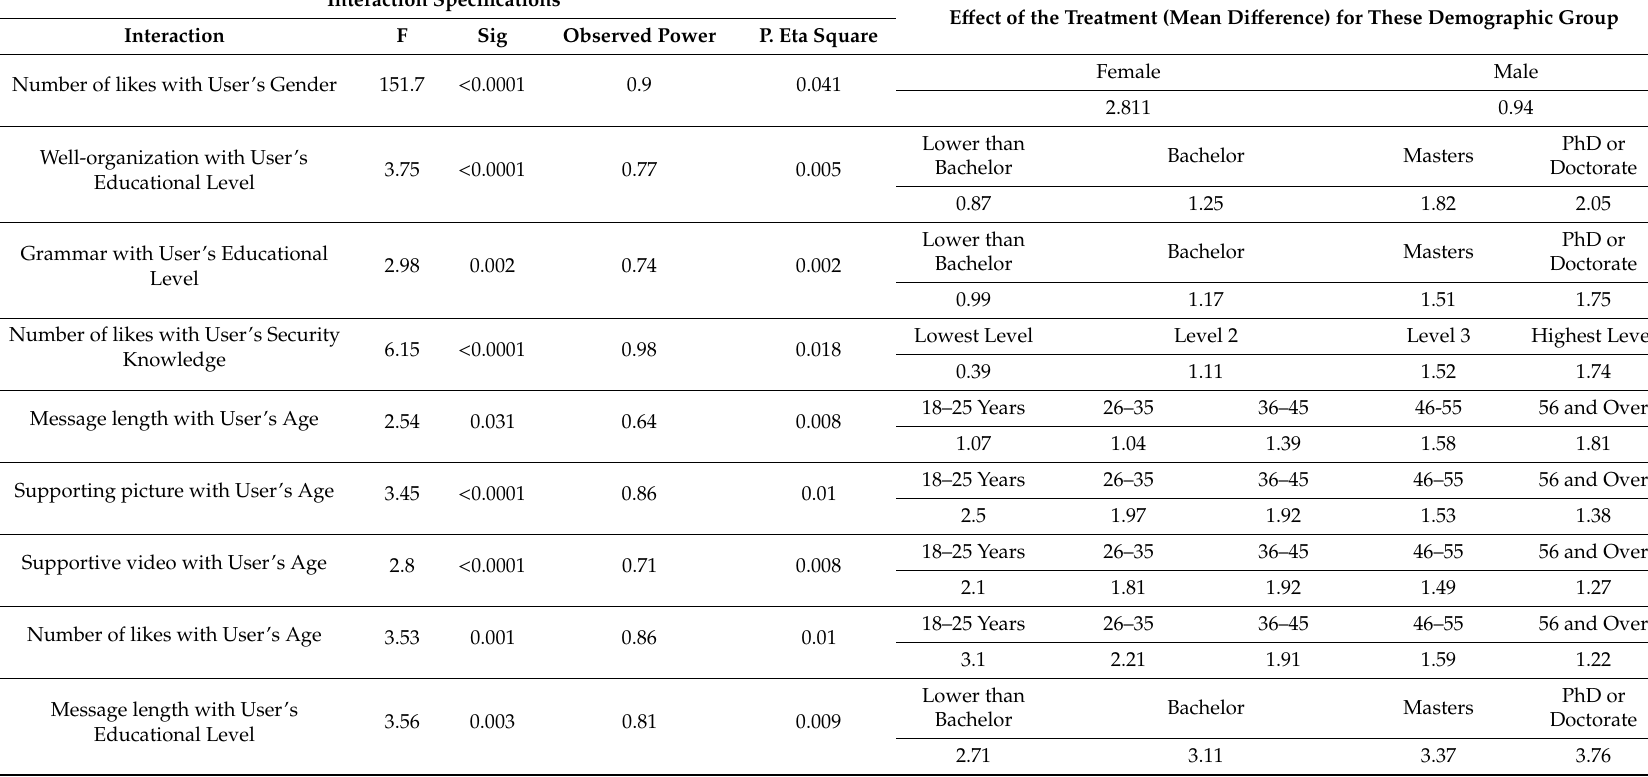
Table 7. Significant interactions between treatment e ff ects and user